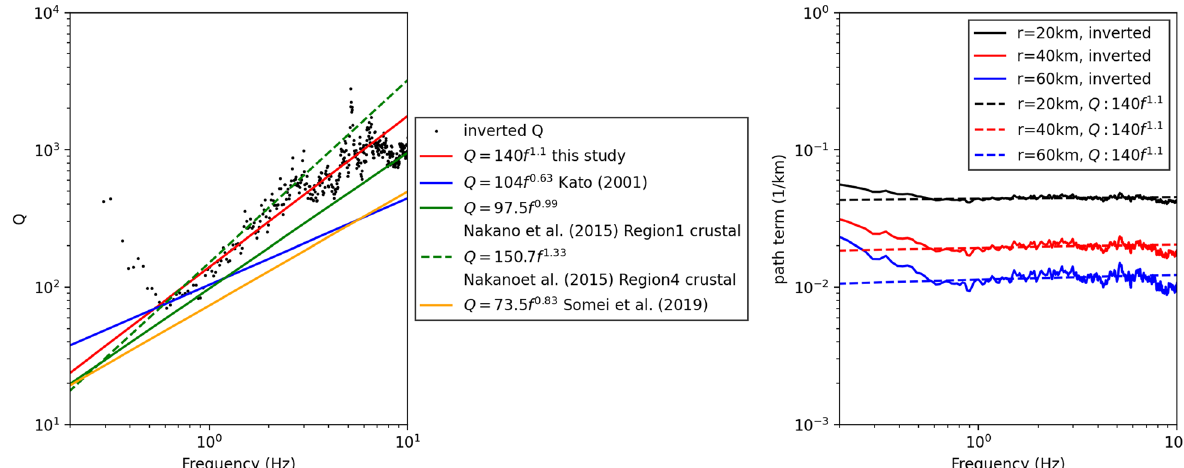
Fig. 3 Inverted Q -value and behavior of the path factor. (Left) Black dots indicate the inverted Q -values by the spectral inversion. The red line indicates the linear approximation of the inverted Q -value. Blue, green, green dashed, and yellow lines indicate the Q -values estimated in the area around the Kumamoto earthquakes by Kato (2001), Nakano et al. (2015) in Region 1 for crustal earthquakes, Nakano et al. (2015) in Region 4 for crustal earthquakes, and Somei et al. (2019), respectively. In Nakano et al. (2015), Region 1 includes the west of Kyushu Island and Region 4 includes the east of Kyushu Island. (Right) Black, red, and blue lines indicate the frequency dependence of the path term by the inverted Q -value at distances of 20, 40, and 60 km, respectively. Black, red, and blue dashed lines indicate the frequency dependence of the path term by Q distance of 20, 40, and 60 km,